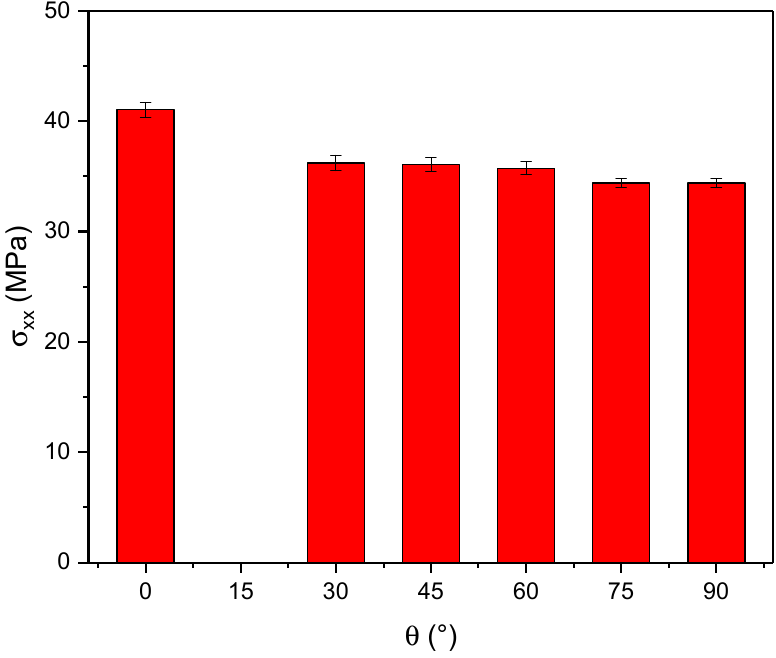
Figure 5. Experimental results from tensile tests.